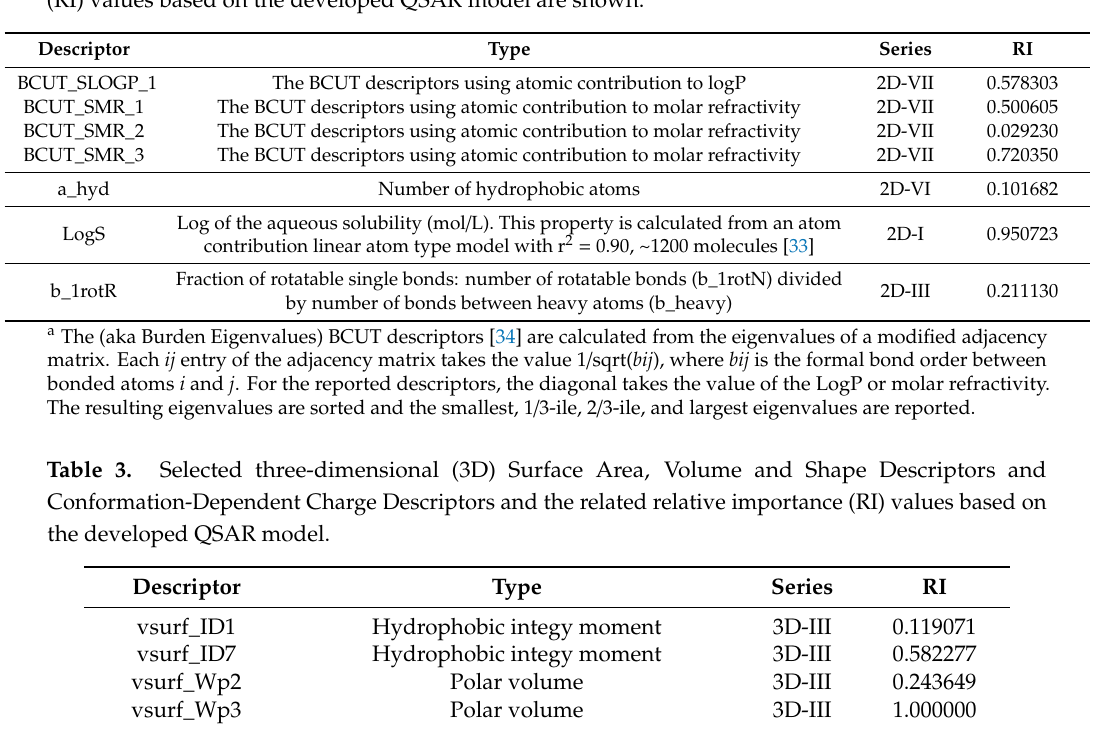
Table 2. Selected 2D Adjacency and Distance Matrix Descriptors. a Pharmacophore Feature Descriptors, Physical Properties and Atom Counts and Bond Counts descriptors. The related relative importance (RI) values based on the developed QSAR model are shown.